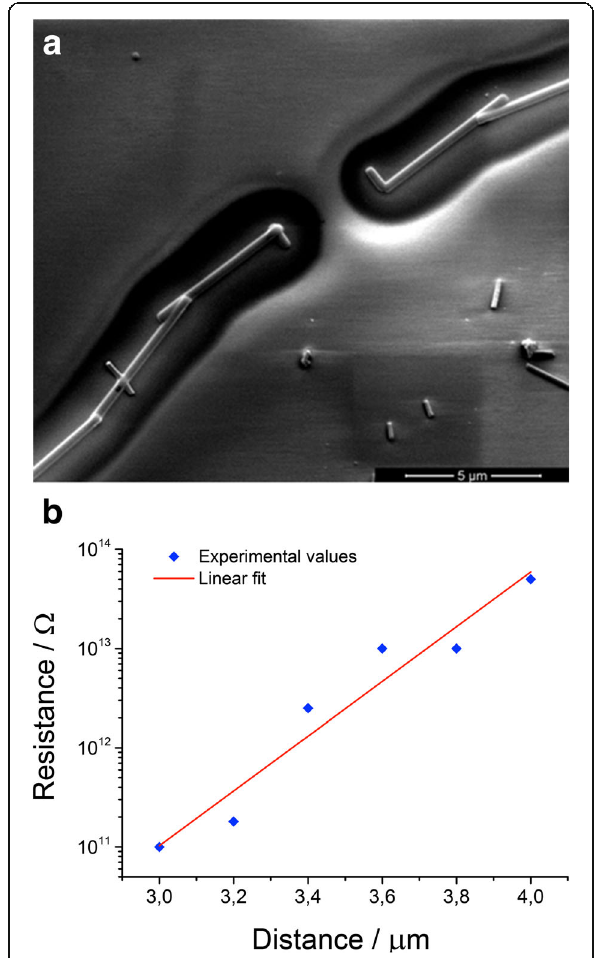
Fig. 3 a SEM images taken at 1 kV of acceleration voltage of a couple of Pt electrodes at 4.0 μ m of distance, made with a layout that minimizes the overlapping area. The relief appearance is explained in the capture of Fig. 2. At this distance, the halos around the Pt electrodes appear to be by around 1 μ m separated. In b , a semi-log graph shows the measured resistance between the electrodes as a function of the distance. The linear fit points out an exponential law